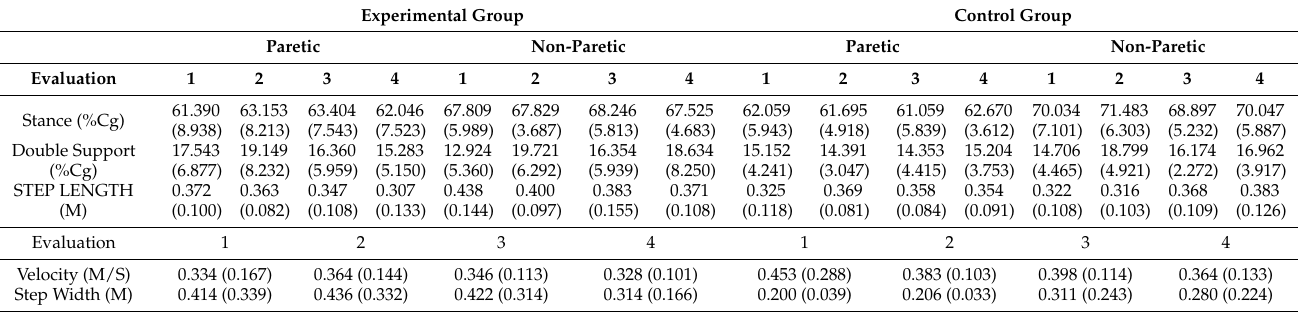
Table 2. Outcomes of spatiotemporal gait variables expressed as mean and standard deviation ( ± SD). Experimental Group Control Group